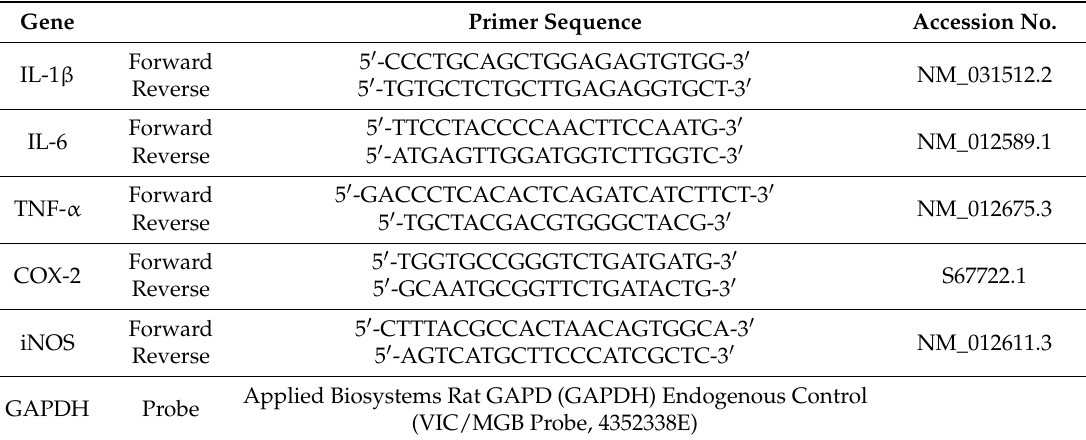
Table 1. Sequences of real-time PCR